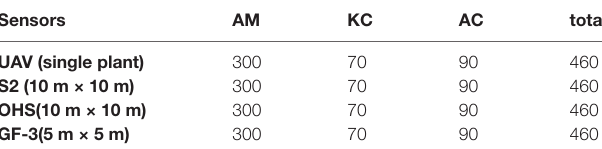
TABLE 2 | Ground LAI measured data based on different image